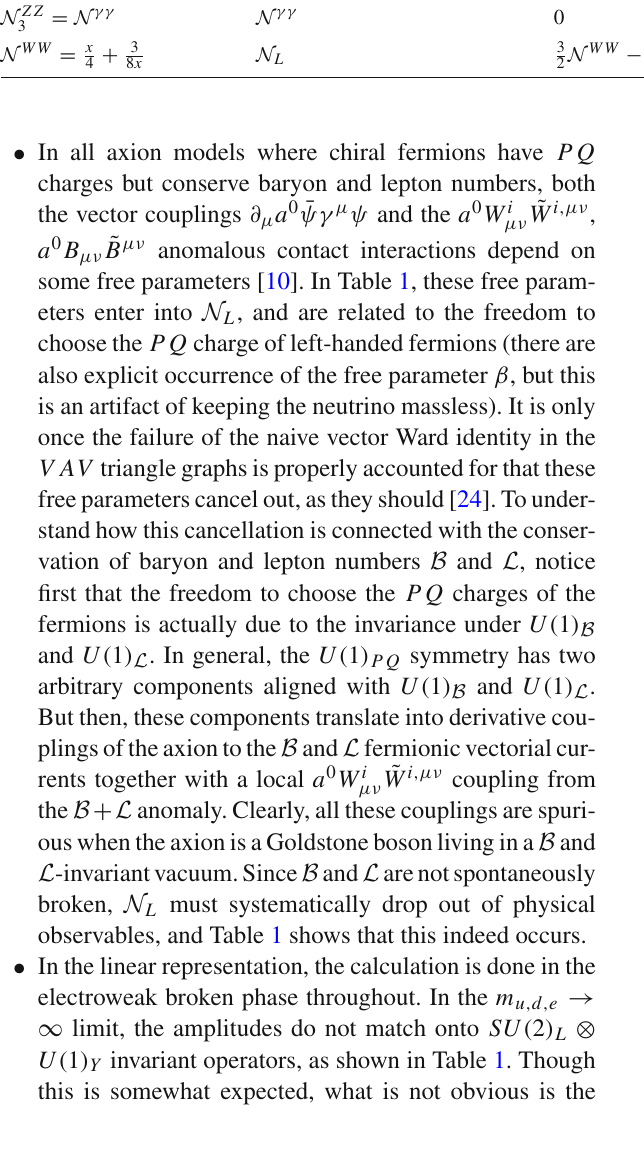
Table 1 Coefficients of the effective axion to gauge boson couplings of Eq. (95) in the m u , d , e → ∞ limit. For the linear representation, those arefounddirectlyfromtheTHDMamplitudesofRef.[21].Forthepolar representation, the contributions of the local anomalous terms and that of the triangle amplitudes built on the axial ( A ) and vector ( V ) deriva- tive interactions have to be added together. The fact that only the three independent coefficients N gg , N γγ , and N L occur for the local anoma- lous interactions comes from their SU ( 2 ) L ⊗ U ( 1 ) Y invariance. The Linear Anomalous